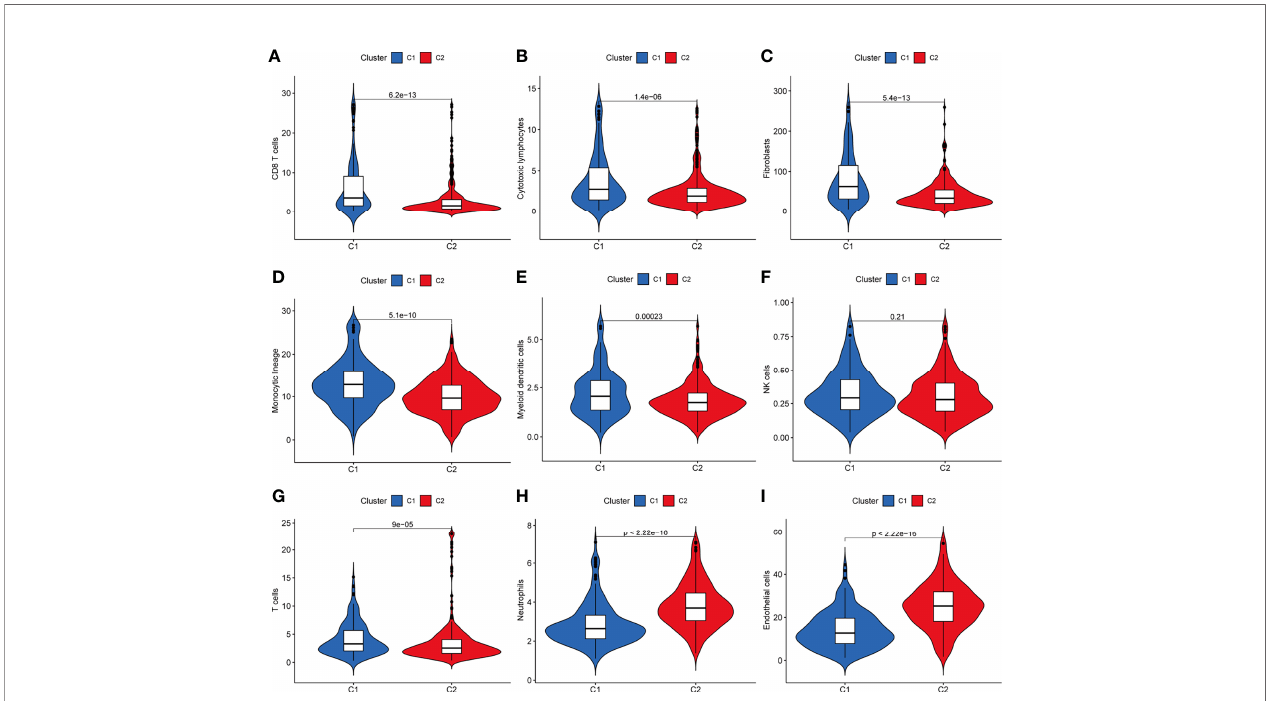
FIGURE 2 | Differences in the distribution of immune cell content via the MCP-counter algorithm between the two clusters of KIRC. (A – I) Patients in the C1 group had higher immune scores of CD8+ T cells, cytotoxic lymphocytes, fi broblasts, monocytic lineage, myeloid dendritic cells, T cells, and lower immune scores for neutrophils and endothelial cells (P < 0.05). MCP-counter, microenvironment cell populations-counter; KIRC, kidney renal clear cell carcinoma.